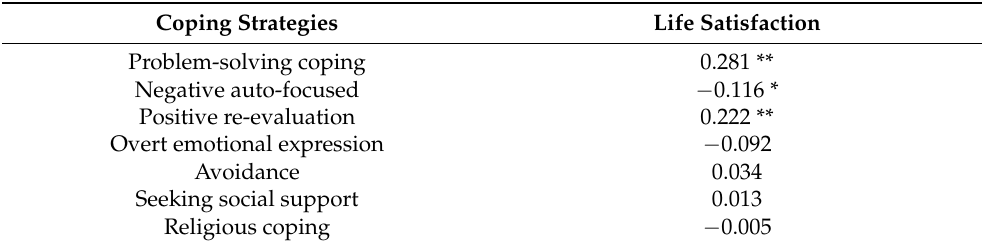
Table 1. Bivariate correlation coefficients between coping strategies and life